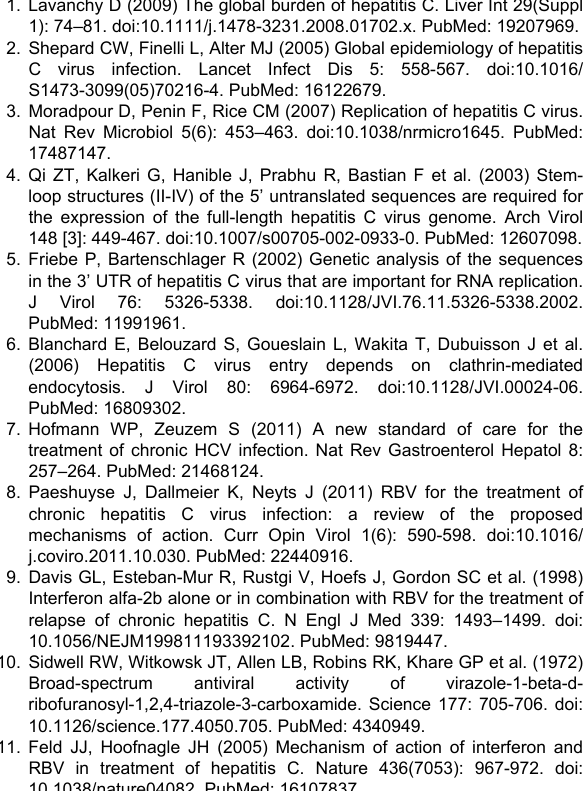
Figure S2. MTT assay showing the effect of IFN-α and RBV combination treatment on viability of Huh-7 and S3-GFP cells.